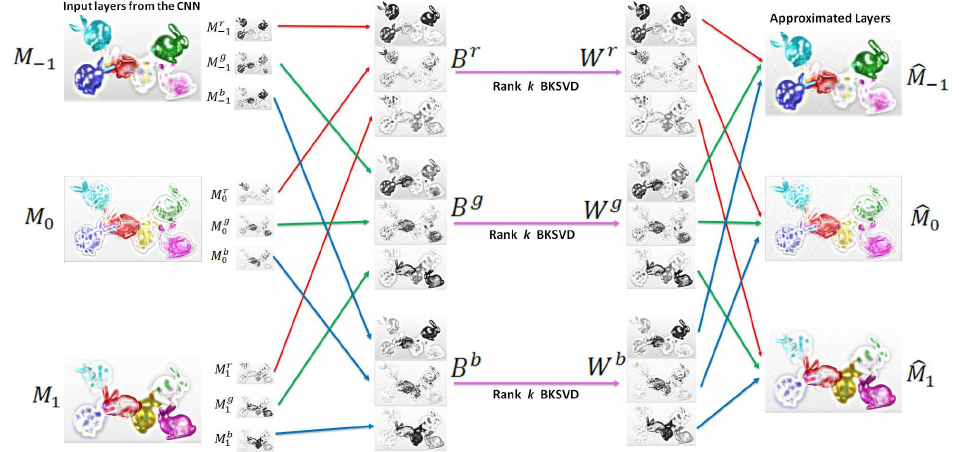
Figure 4. The BK-SVD procedure adopted in the proposed scheme. The layers M z , z ∈ {− 1,0,1 } are split into color channels and rearranged to form matrices B ch , ch ∈ { r , g , b } . The rank k approximation of B ch results in W ch , which are then divided and rearranged to attain the approximated layers. Given a matrix B ∈ R c × d of rank r , the SVD can be performed as B = U Σ V T , where the left and right singular vectors of B are the orthonormal columns of U ∈ R c × r and V ∈ R r × d , respectively. Σ ∈ R r × r is a positive diagonal matrix containing σ 1 ≥ · · · ≥ σ r